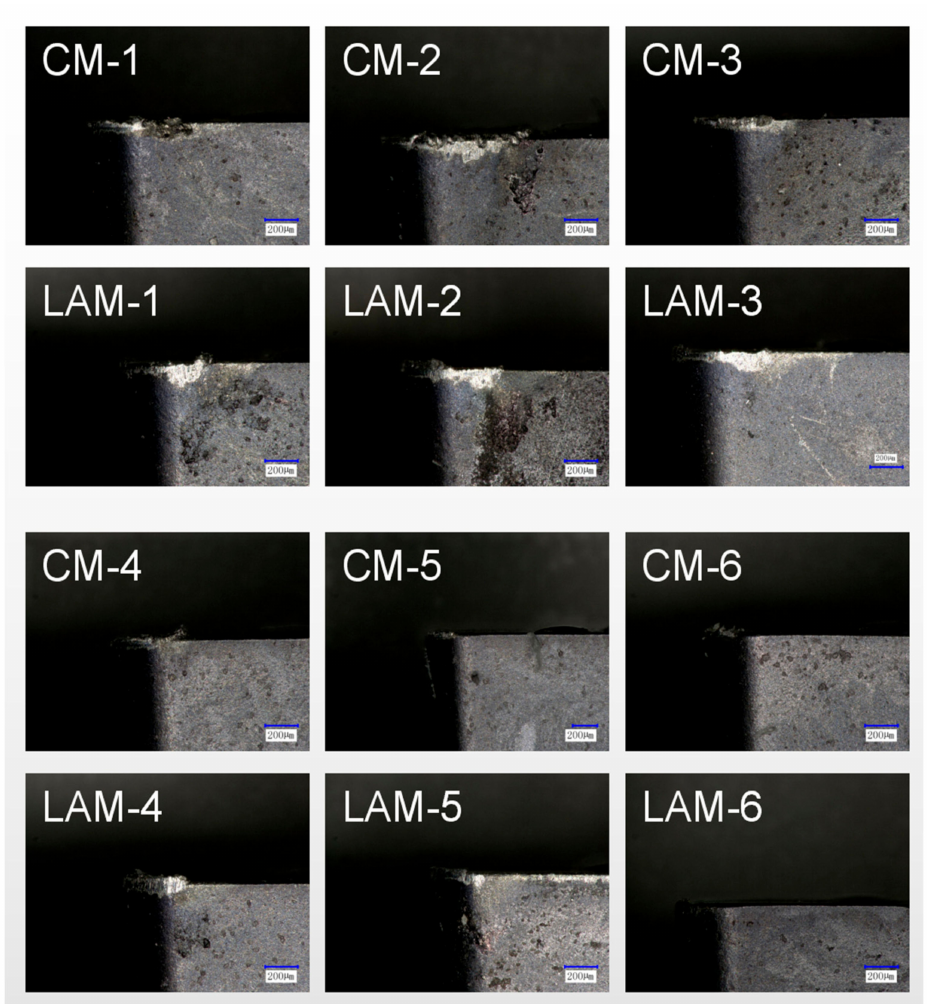
Figure 7. Comparison of flank wear morphologies via conventional machining and laser-assisted machining.